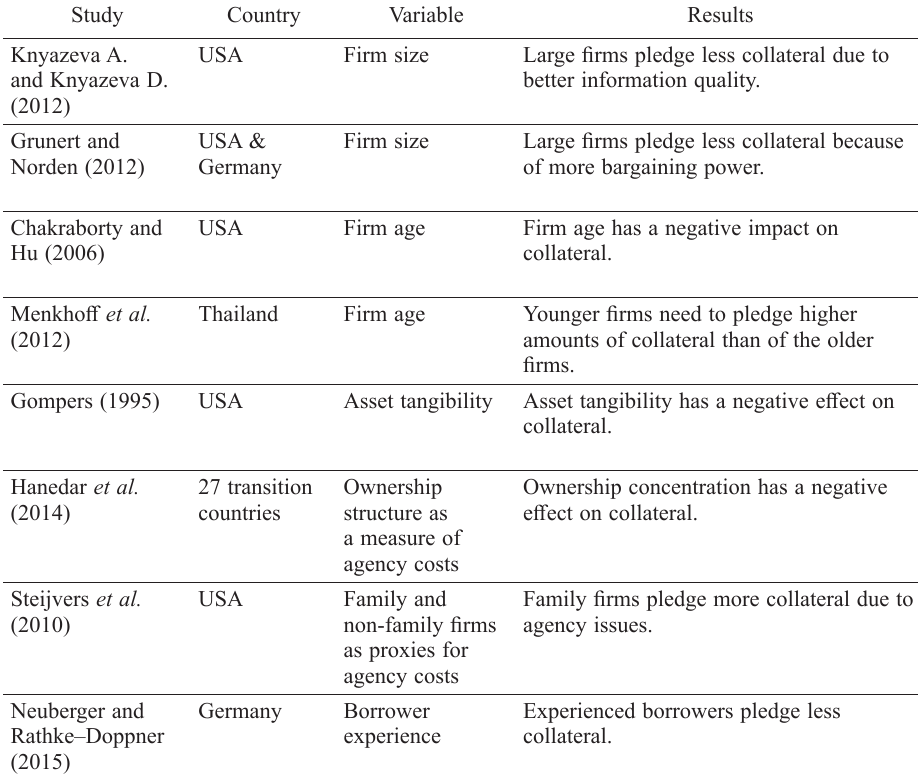
Table 1. A summary of studies based on firm characteristics, loan characteristics, and lender market characteristics and their impact on collateral requirements on SMEs Study Country Variable Results Large firms pledge less collateral due to better information